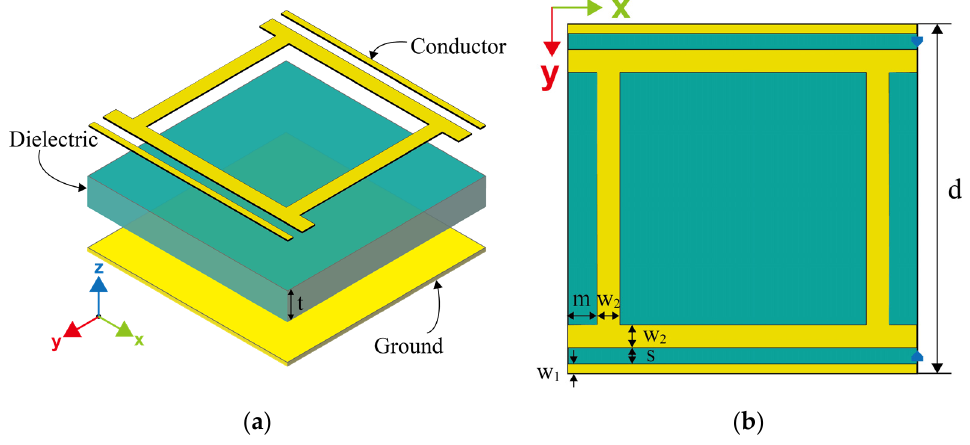
Figure 1. Schematic of the metasurface array unit cell. ( a ) 3-D view. ( b ) Top view. The boundary of both sides of the metasurface unit cell is d = 21 mm. Microstrip lines